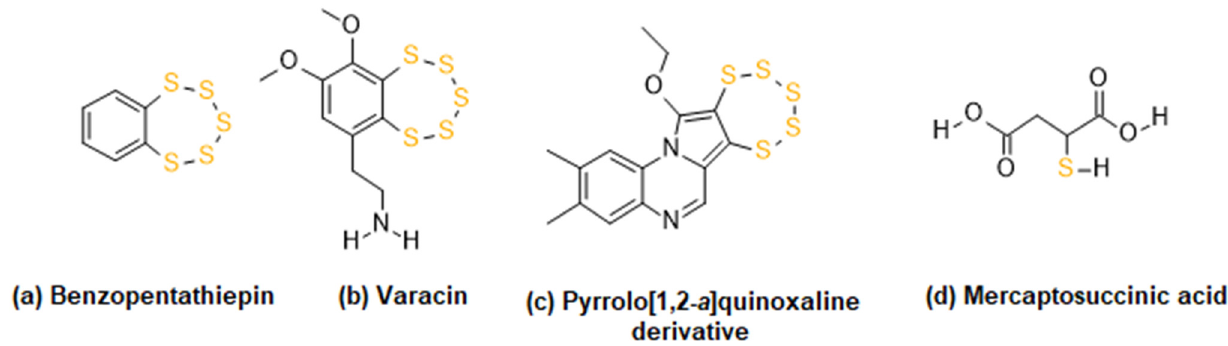
Figure 1. Chemical structures of ( a ) benzopentathiepin as one of the first synthesized pentathiepins; ( b ) varacin as the first isolated natural pentathiepin; ( c ) a pyrrolo[1,2- a ]quinoxaline-based pentathiepin from our previous study; and ( d ) mercaptosuccinic acid, an inhibitor of the GPx1.